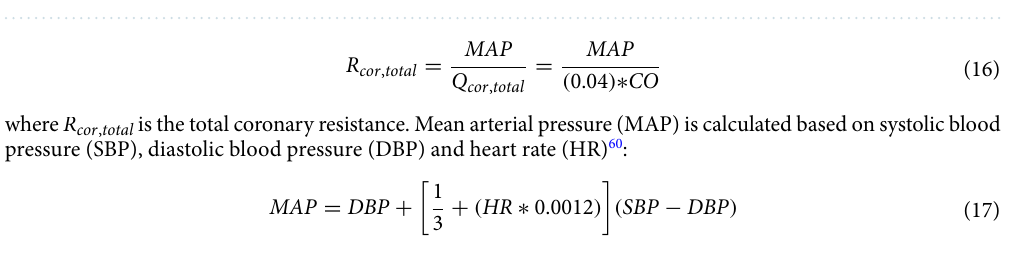
Figure 12. 3D distribution contours of Mises stress at peak diastole in patient#1 and patient#2 between baseline and 90-day